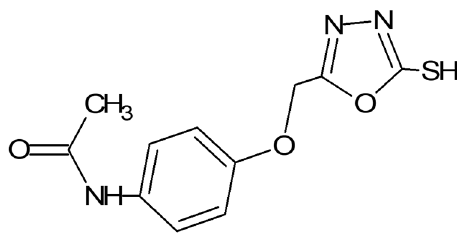
Figure 1. Structure of novel synthetic compound A3. N -{4-[(5-sulfanyl-1,3,4-oxadiazol-2-yl)methoxy]phenyl}acetamide.